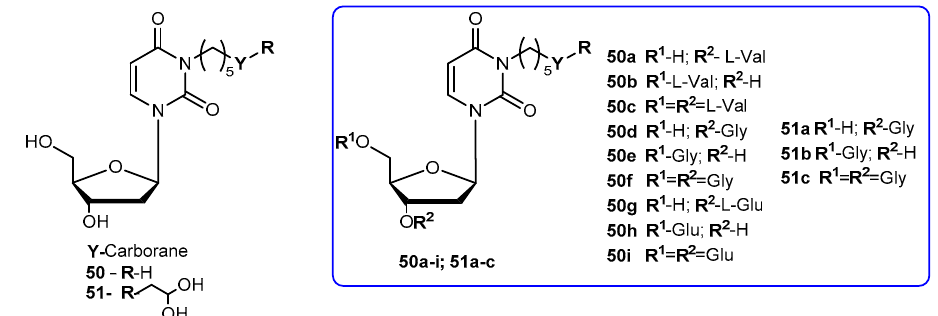
Figure 23. Chemical structures of 3-carbonyl thymidine analogs, N5 ( 50 ) and N5-2-OH ( 51 ) and its amino acids prodrugs 50a – i and 51a – c .